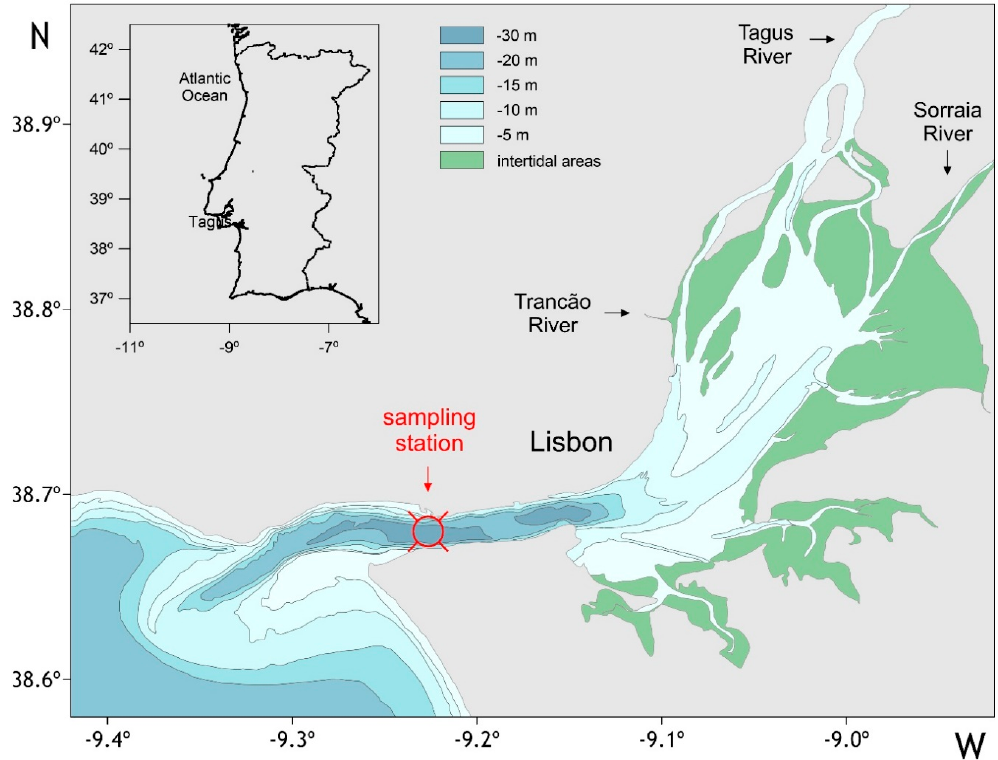
Figure 1. Map of Tagus estuary (SW Portugal) showing the location of the fixed sampling station.